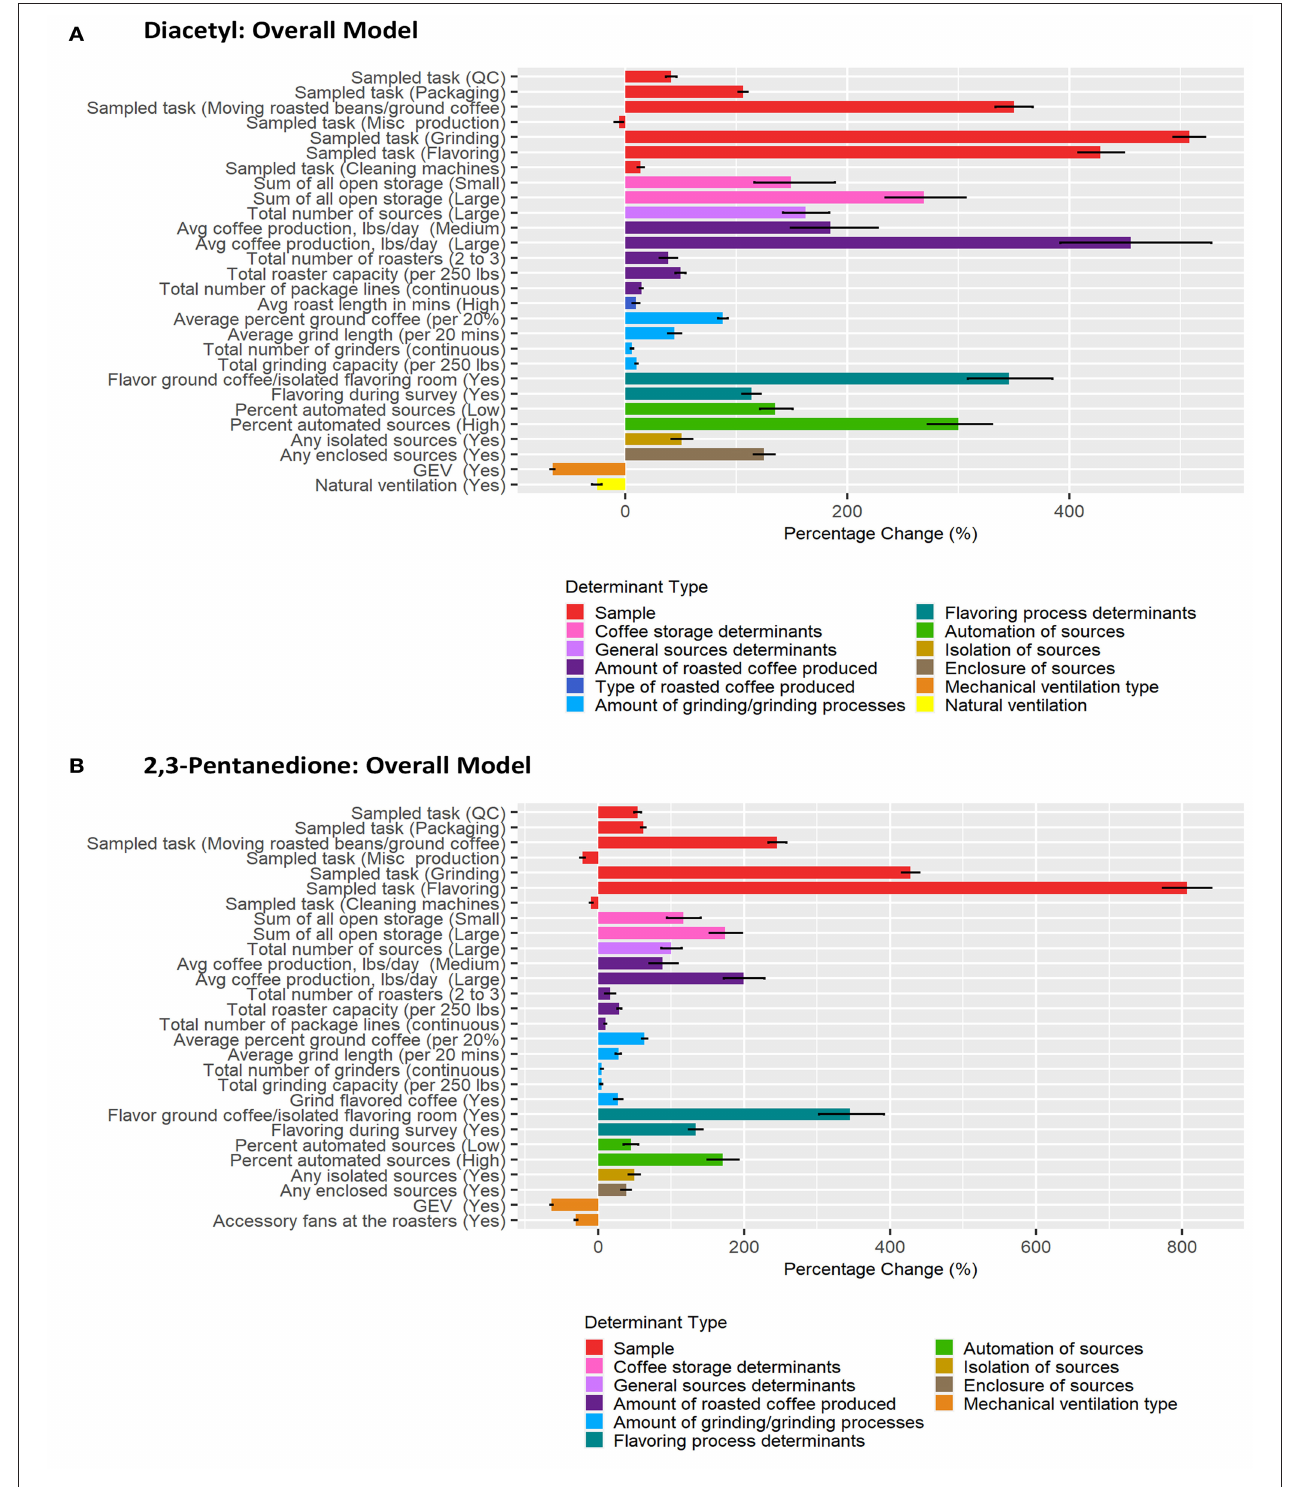
FIGURE 3 | Bar chart of percent change in diacetyl (A) and 2,3-pentanedione (B) exposures during all tasks (overall model) compared with reference category or per unit change. Each bar represents the estimated percent change for the median posterior estimate with error bars for the 95% credible intervals. Percent change for continuous variables defined as per 1 unit with the exceptions of the following: total roaster capacity and total grinder capacity are calculated per 250 lbs, average percent ground coffee is calculated per increase in 20%, and average grind length in minutes is calculated per 20min.